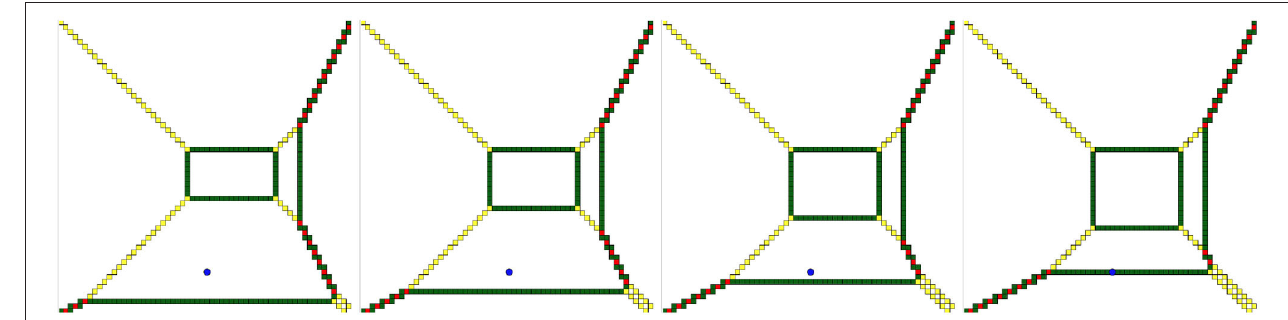
FIGURE 6 | For a given sandpile state we apply several times the wave operator at the blue point p . One can see that the line-shaped pattern around p point creeps toward p until it belongs to one on them. Recall that white cells contain 3 grains, so the deviation set is the green, yellow, and red cells, which belong to a small neighborhood of a certain tropical curve. Let us present this tropical curve as a corner locus of a pointwise minimum of several linear functions (cf. Figure 5 ), i.e., as an (cid:127) -tropical series F . The planar graph is then the projection of edges of a three-dimensional polytope (the graph of F ). Then the action of the wave operator corresponds to shifting one of the faces of this polytope, i.e., increasing by one the constant coefficient of the linear function, defining this face. On the level of planar graphs, we take the linear function in F (see Equation 1), which is the minimal at p , and increase its constant coefficient until p belongs to the corner locus of the new piecewise linear